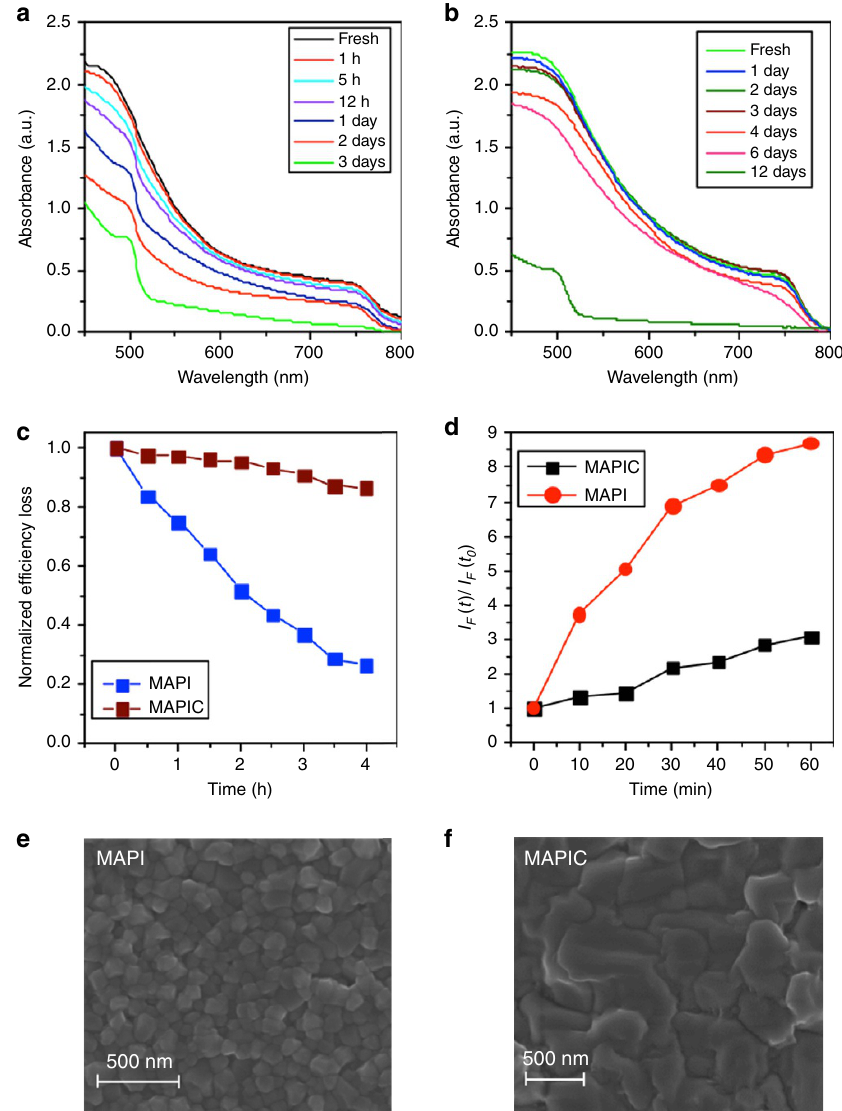
Figure 3 | Stability comparison of CH 3 NH 3 PbI 3 and CH 3 NH 3 PbI 3 (Cl). ( a , b ) Light absorption spectrum for ageing CH 3 NH 3 PbI 3 and CH 3 NH 3 PbI 3 (Cl) under dry air and illumination (25mWcm (cid:2) 2 ) respectively. ( c ) Normalized power conversion efficiency loss for photovoltaic devices employing CH 3 NH 3 PbI 3 (referred to as MAPI) and CH 3 NH 3 PbI 3 (Cl) (referred to as MAPIC) as the light harvesting materials in an [FTO/planar-TiO 2 /mesoporous- TiO 2 /perovskite/spiro-OMeTAD/Au] architecture. J-V curves obtained for these studies are shown in Supplementary Fig. 4. ( d ) Normalized fluorescence intensity increase of the HE probe at 610nm (excitation at 520nm). I F ( t ) is the fluorescence maximum at time t , while I F ( t 0 ) is the background fluorescence intensity. I F ( t )/ I F ( t 0 ) ratio corresponds to the yield of superoxide generation for the perovskite films. ( e , f ) Surface SEM images of CH 3 NH 3 PbI 3 and CH 3 NH 3 PbI 3 (Cl) films deposited on cleaned glass